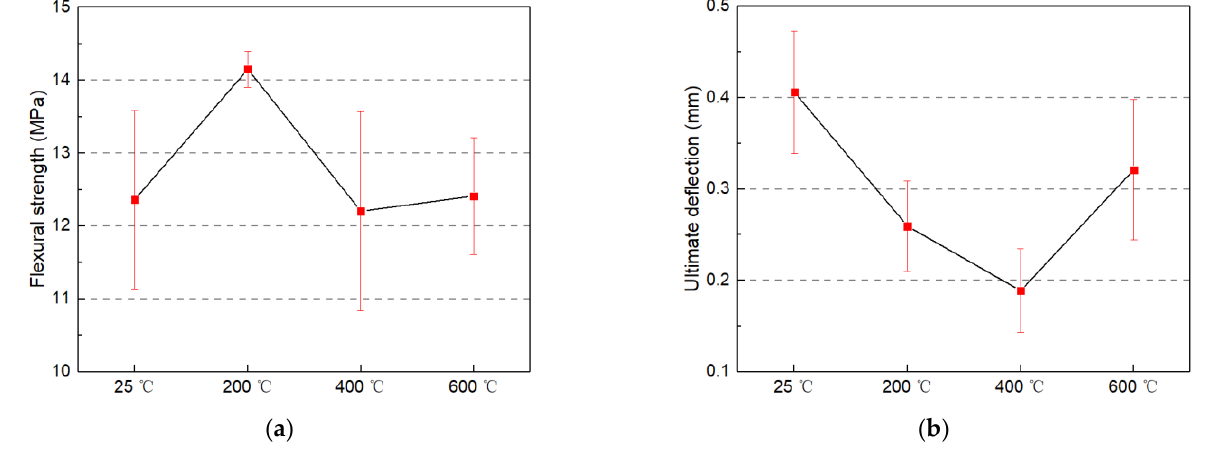
Figure 3. Bending performance: ( a ) Flexural strength; and ( b ) Ultimate deflection of heated multi-scale fiber reinforced cement matrix composite (MSFRC).